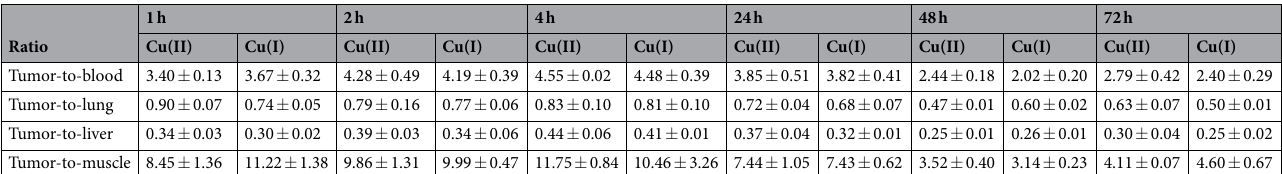
Table 2. Tumor-to-non tumor Ratios of 64 Cu(II) and 64 Cu(I) in B16F10 Tumor-Bearing Mice (n = 4).